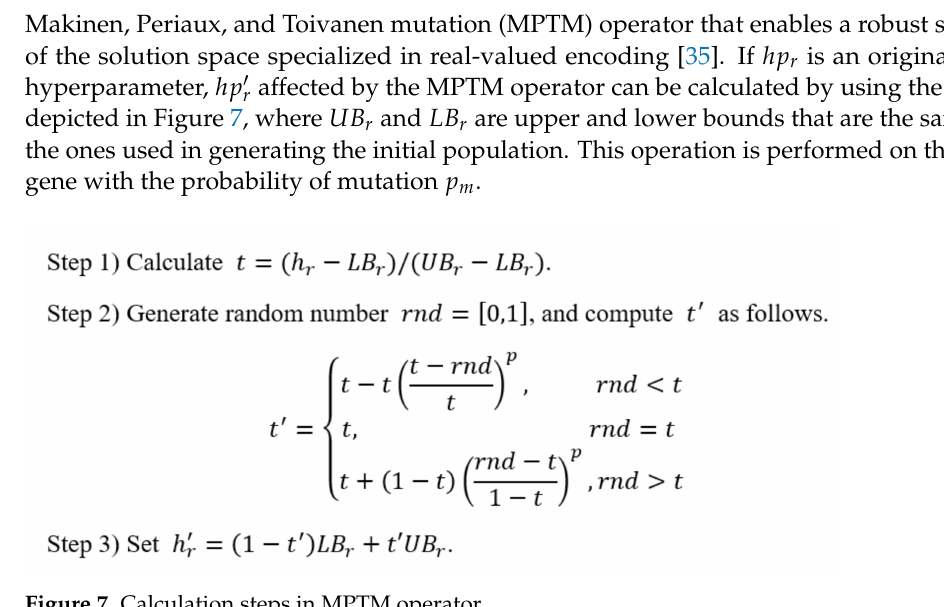
Figure 7. Calculation steps in MPTM